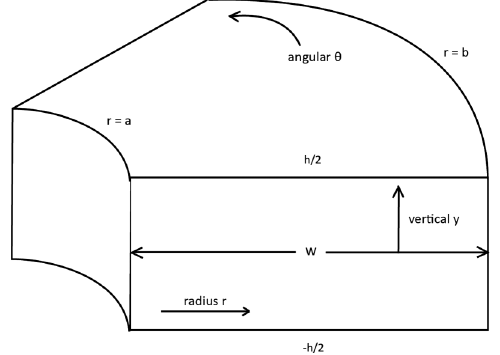
FIG. 1. A segment of a rectangular vacuum chamber in the cylindrical